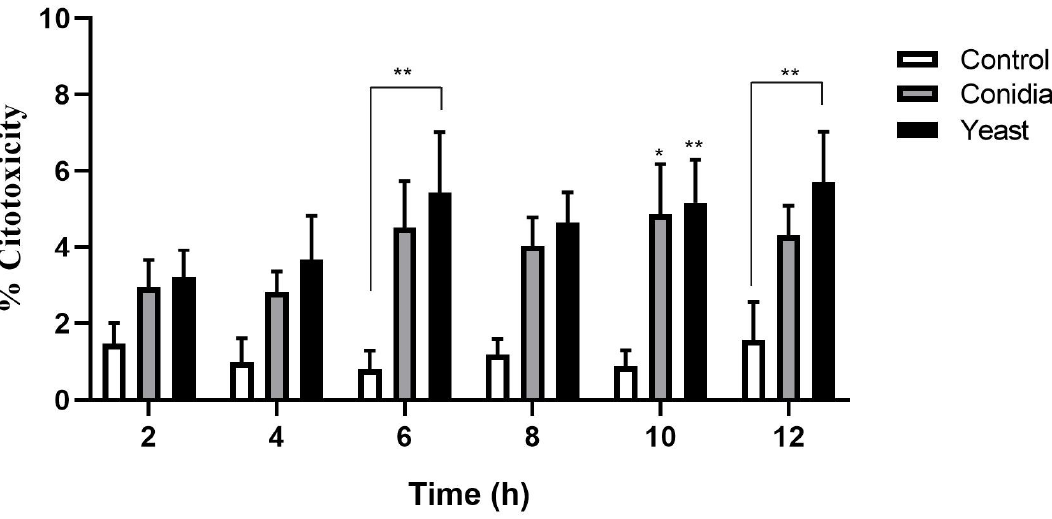
Figure 1. Cytotoxicity of keratinocytes during infection by conidia and yeast cells of S. schenckii . Cell infection kinetics were performed with conidia and yeast cells of S. schenckii in keratinocytes with a 1:1 MOI, for 12 h. At each post-infection time, the cell culture supernatants were recovered. The assessment was performed with the CytoTox 96 ® Assay commercial kit using lactate dehydrogenase (LDH) detection. The data are presented as the mean ± standard deviation (SD) of three independent experiments. * p < 0.05, ** p < 0.005.